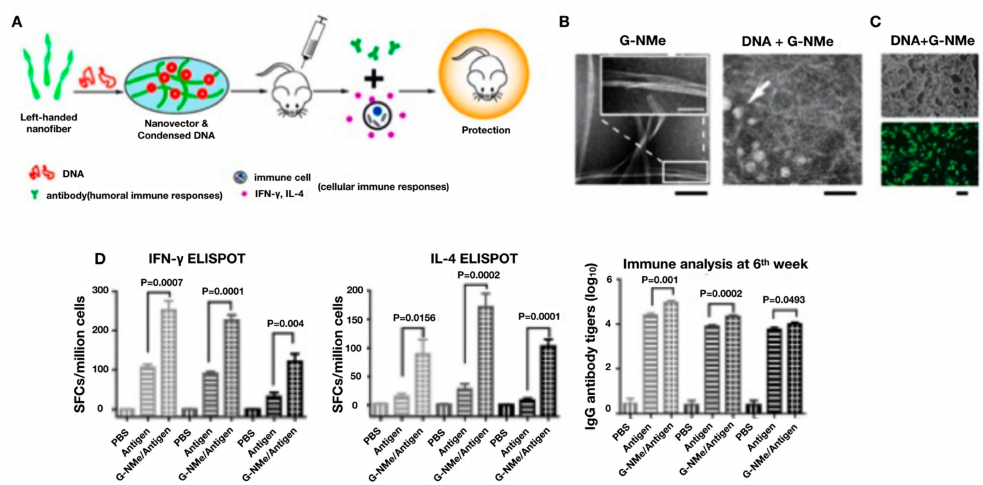
Figure 10. Peptide-based nanofibrous hydrogel HIV DNA vaccine. ( A ) Schematic of synthesis, immunization and immune response generated from peptide-based nanofibrous hydrogel HIV DNA vaccine. ( B ) G-NMe nanovectors imaged with TEM. Scale bar: 100 nm (black); 50 nm (white). ( C ) Fluorescence images of 293 T cells transfected by G-NMe nanovector / EGFP plasmid. Scale bar: 100 µ m. ( D ) Results of ELISPOT assays indicating cellular immune responses induced by GNMe /